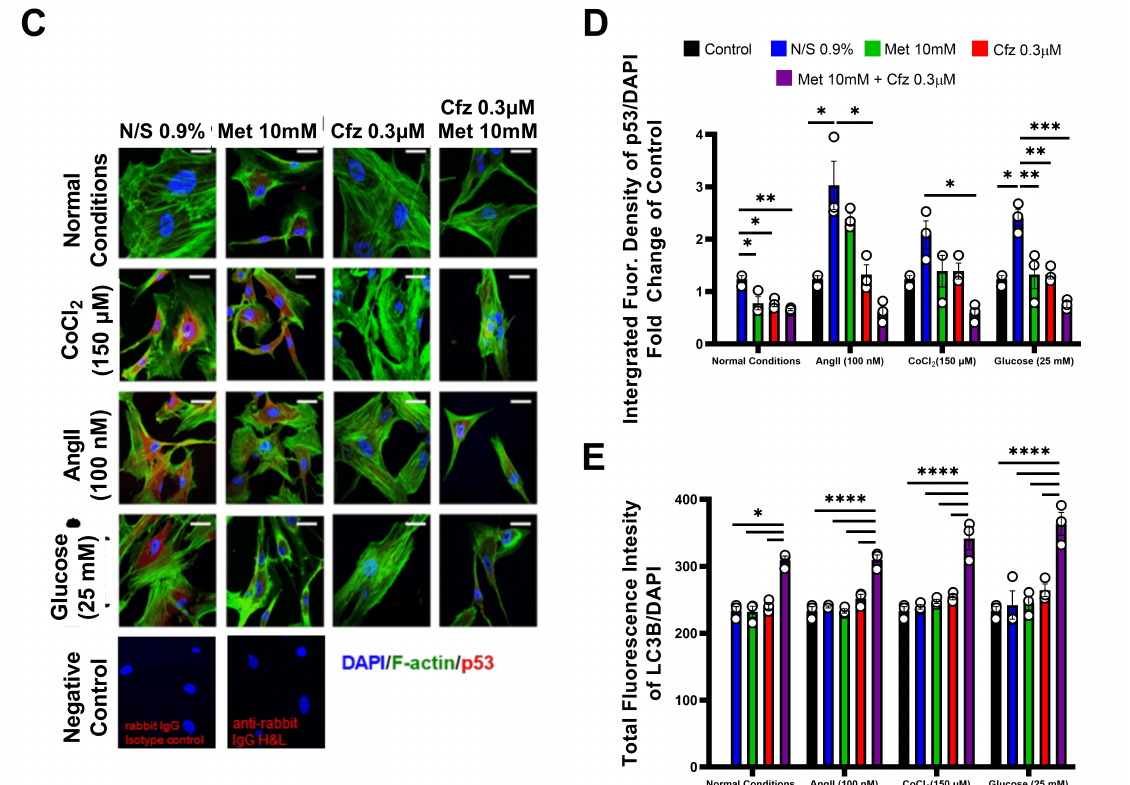
Figure 8. Cfz + Met synergistically induce autophagy in senescent human aorta smooth muscle cells (HAoSMCs) in the presence of cardiovascular risk stimuli in vitro. Graphs of ( A ) MTT absorbance (540 nm, n = 3–5 per group) and ( B ) cellular confluency expressed as the fold change of the control (untreated senescent HAoSMCs; * p < 0.05, ** p < 0.01, *** p < 0.01, **** p < 0.001; one way ANOVA, Tukey’s multiple comparison test; n = 3 per group). ( C ) Representative immunofluorescence confocal images of HAoSMCs under normal conditions (untreated cells) or in the presence of AngII (100 nM), CoCl2 (150 µ M) and high-glucose (25 mM). ( D ) Integrated fluorescence density of p53 / DAPI expressed as the fold change of the control (untreated senescent HAoSMCs) and ( E ) total fluorescence intensity of LC3B / DAPI as measured in the automated microscope per well (mean total fluorescence intensity of individual VSMCs in the well; * p < 0.05, ** p < 0.01, *** p < 0.005, **** p < 0.001; one way ANOVA, Tukey’s multiple comparison test; n = 3 per group). Data are presented as mean ± SEM and individual values are presented as scatter column graphs. Black columns represent the control (untreated cells), blue columns represent Normal Saline (NS) 0.9%, red columns represent Cfz (0.3 µ M), green columns Met (10 mM) and purple columns Cfz + Met (0.3 µ M, 10 mM respectively). Cfz, carfilzomib; Met, metformin; HAoSMCs, human aorta smooth muscle